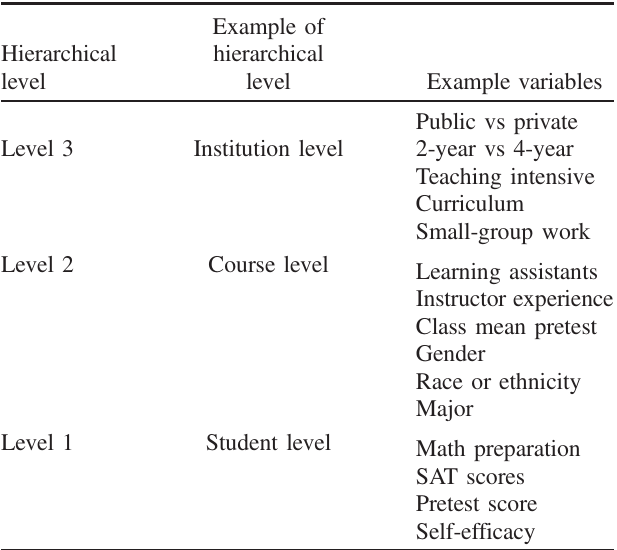
TABLE I. Factors at each hierarchical level that may affect students ’ concept inventory post-test score.